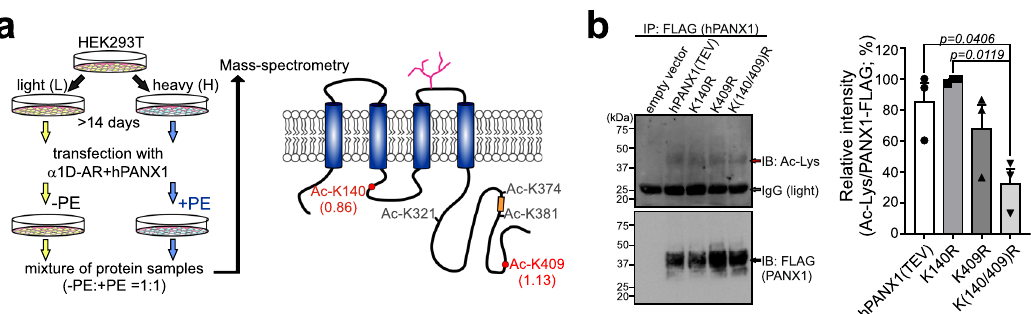
Fig. 6 Identi fi cation of acetylated lysine sites on PANX1. a SILAC/MS analysis of hPANX1-Strep immunoprecipitated from control or PE-treated α 1D-AR/ hPANX1-transfected HEK293T whole-cell lysates revealed multiple lysine acetylation sites on hPANX1 (from n = 3 biological replicates). Abundance levels for the acetylated forms of K140 or K409 in the cognate peptides were normalized to the median abundance of PANX1 and calculated as a ratio of PE- treated (H): vehicle-treated (L) for Lys-140 (0.86 ± 0.02; 0.88, 0.88, 0.83) and for Lys-409 (1.13 ± 0.71; 0.92, 0.02, 2.44). Other lysine sites (K321, K374, or K381) were inconsistently acetylated at baseline across the three samples and/or unaffected by PE treatment. b Example acetyl-lysine blot of immunoprecipitated FLAG-tagged and Arg-substituted hPANX1(TEV) constructs (left); acetyl-lysine signal was fi rst normalized relative to FLAG, and then to peak acetyl-lysine signal for comparisons across experiments (right, n = 3 independent experiments). Data are presented as mean ± s.e.m. One-way ANOVA (F 3,8 = 6.735, p = 0.0140) with Bonferroni ’ s multiple comparisons test ( p values from comparisons are shown).